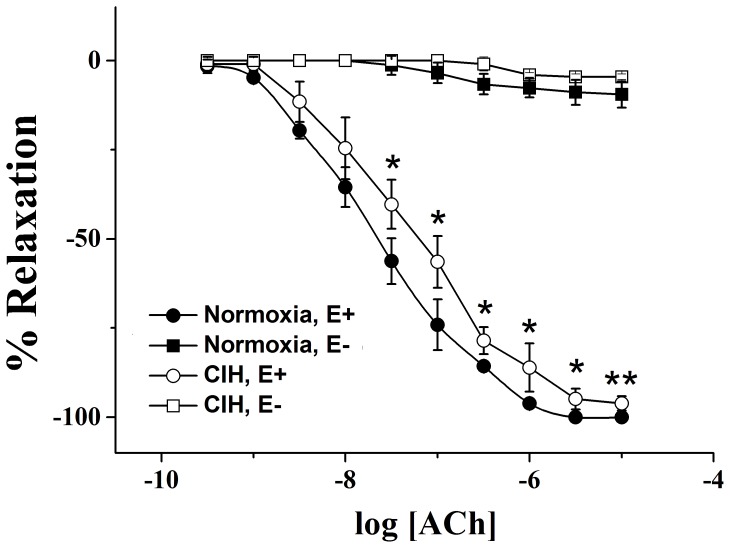
Effects of Ach on relaxation of rings in E+ and E− of normoxic and CIH rats pulmonary arteries.Pulmonary artery rings were pre-contracted with PE (10−6 M), and relaxation to ACh was detected. Relaxant responses to ACh were expressed as a percentage of PE-induced tone. Data were means ± SD; n = 6. **
P<0.01, *
P<0.05, relative to normoxia, E+.